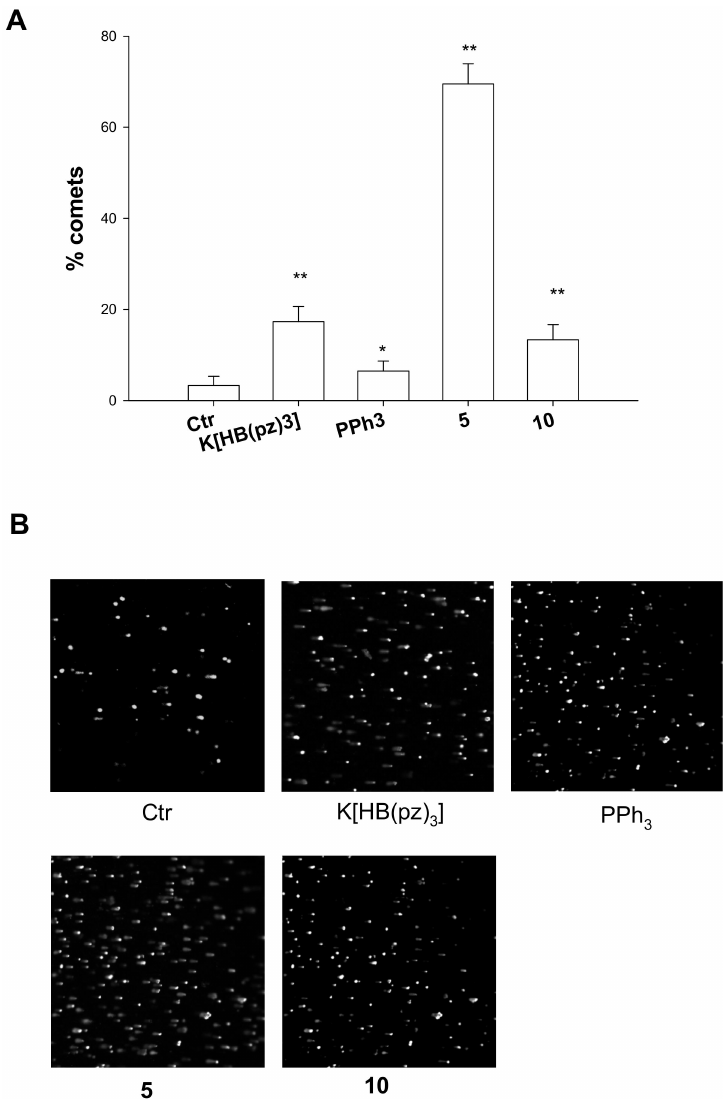
Figure 2. Comet assay; 2008 cells were treated for 6 h with IC 50 values of tested compounds and then processed for comet assay. ( A ) Number of cells with well-formed comets measured by ImageJ software. The error bars indicate the S.D. * p < 0.01; ** p < 0.05( B ) Representative images of 2008